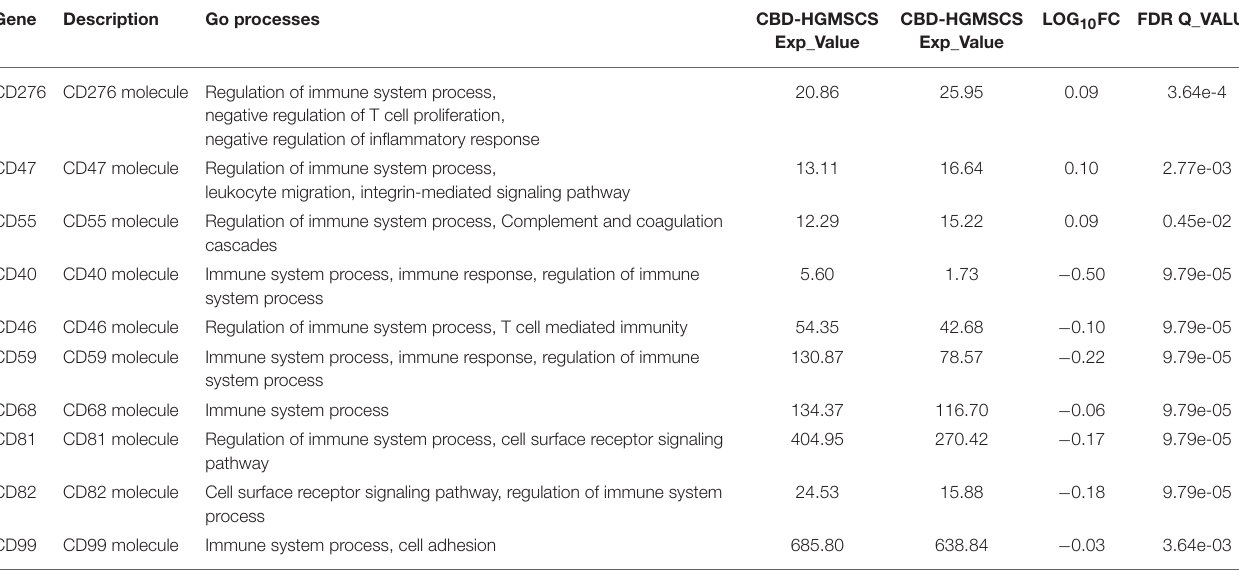
TABLE 5 | CBD modulated the transcription of genes codifying for the antigenic repertoire of hGMSCs.